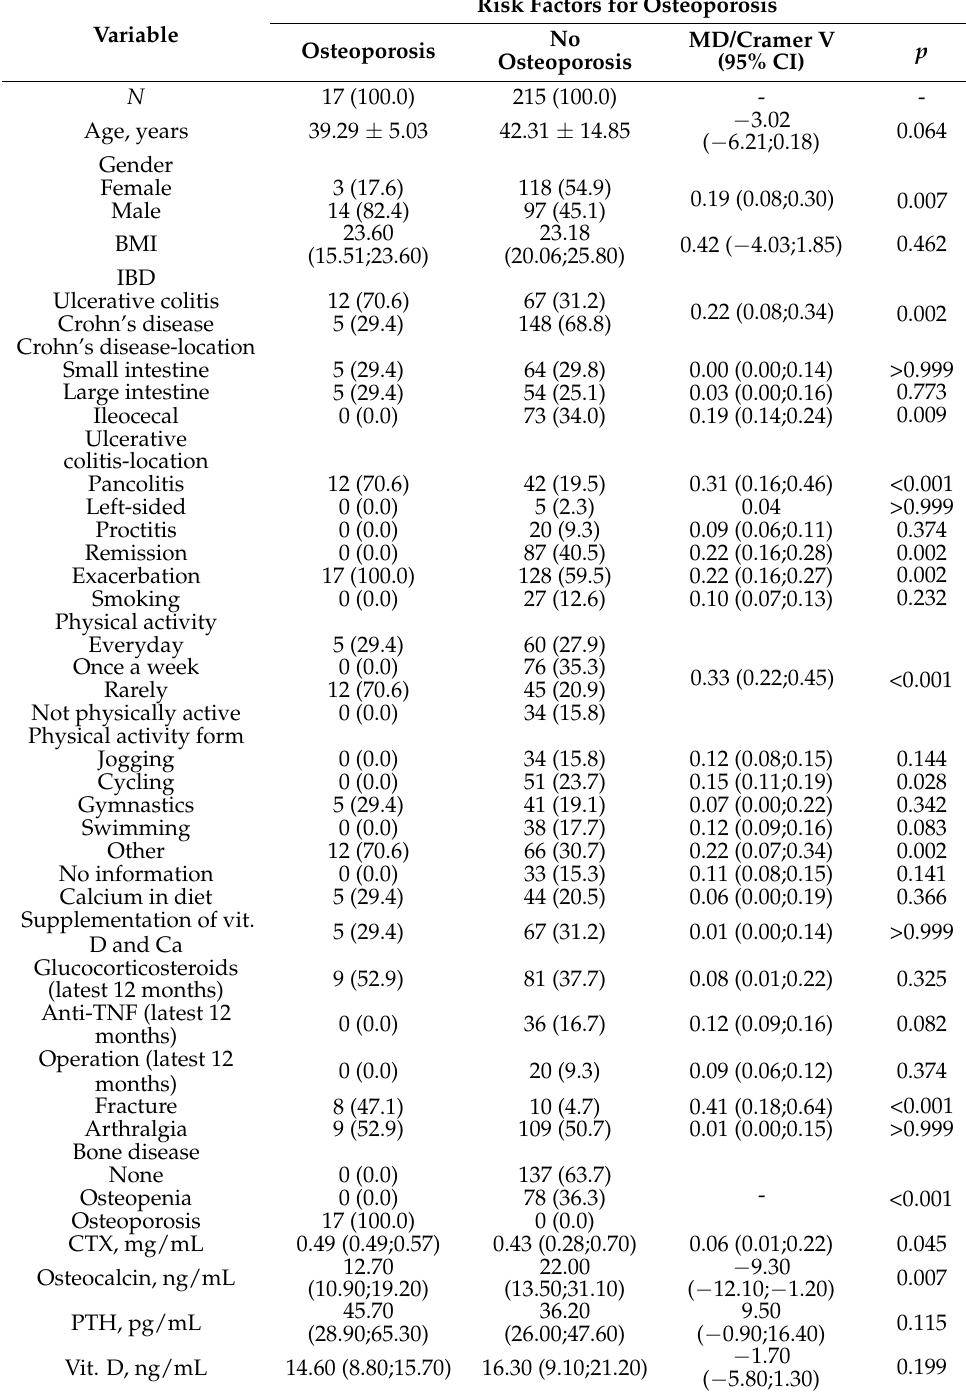
Table 2. Risk factors for osteoporosis in patients with